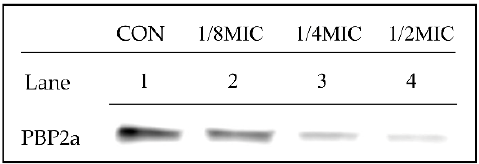
Figure 3. The expression of PBP2a in MRSA (ATCC 33591) cultures in the presence of various concentrations of BDMC. The PBP2a production was reduced significantly after exposure to S. aureus strains with 1/8 MIC BDMC (Lane 2), 1/4 MIC BDMC (Lane 3) and 1/2 MIC BDMC (Lane 4). CON, untreated control MRSA. (Lane 1).